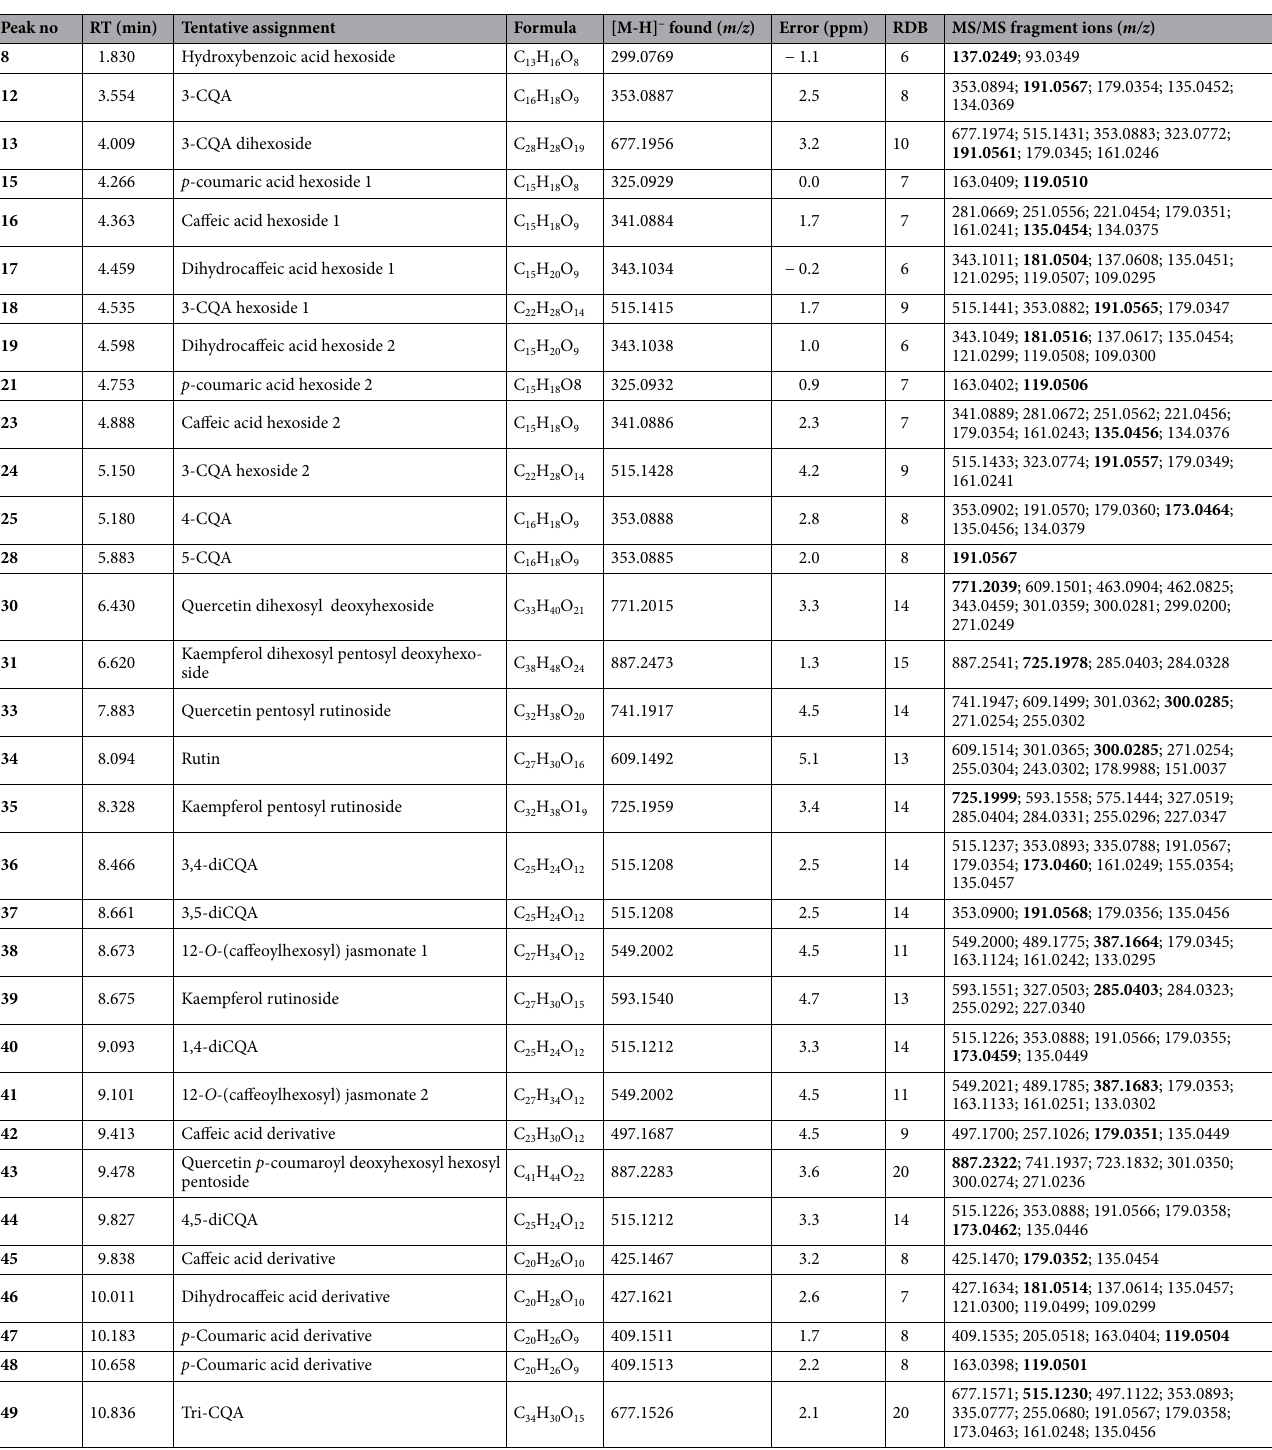
Table 2. UHPLC-ESI-QqToF/MS and MS/MS data useful for tentative identification of phenolic compounds in hydro-alcoholic extracts (base peaks in MS/MS spectra are reported in bold; RT = retention time; RDB = ring and double bond value). MS/MS spectra are reported as Supplementary